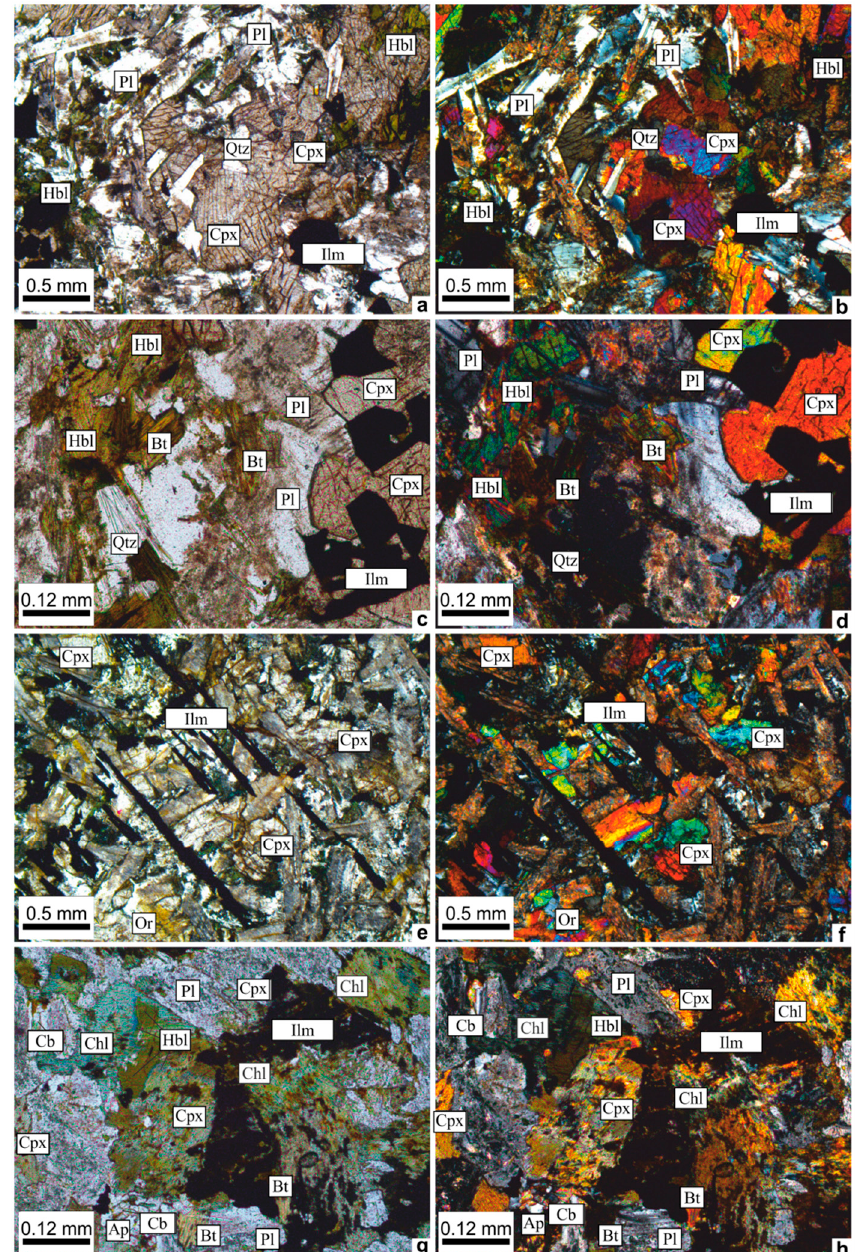
Figure 3. Microphotographs of ( a – d ) low-altered dolerite dyke L15-19 (the same dyke as X04-29) and ( e – h ) high-altered dolerite sill L15-13. See location in Figures 1 and 2. In both samples, plagioclase (Pl) is replaced by chlorite (Chl) and carbonate (Cb), whereas clinopyroxene (Cpx) is replaced by hornblende (Hbl) and biotite (Bt). Other minerals: Ap—apatite, Ilm—ilmenite, Qtz—quartz, and Or—orthoclase.